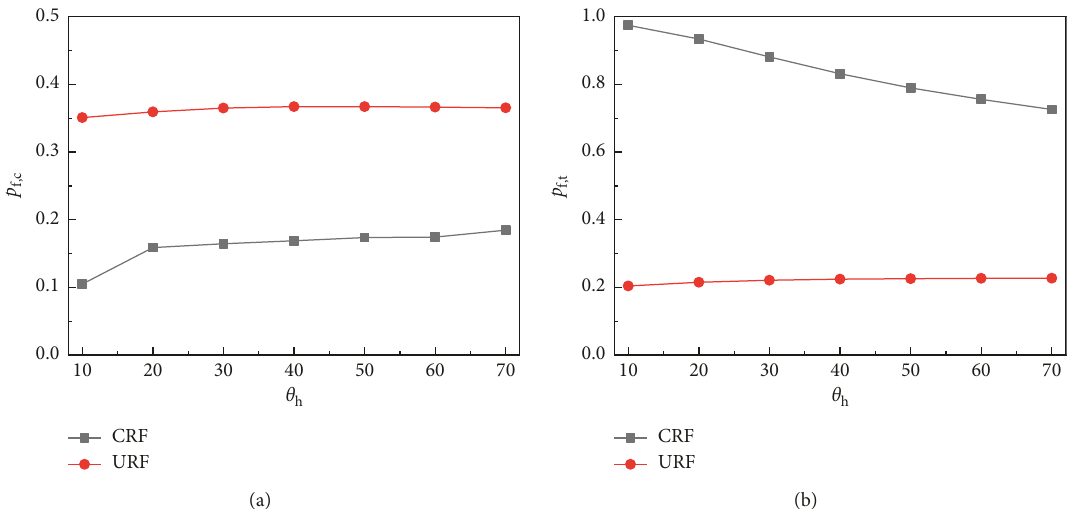
Figure 7: Effect of the horizontal correlation length on the probability of failure of tunnel liner under both unconditional and conditional random fields: (a) compression failure and (b) tension